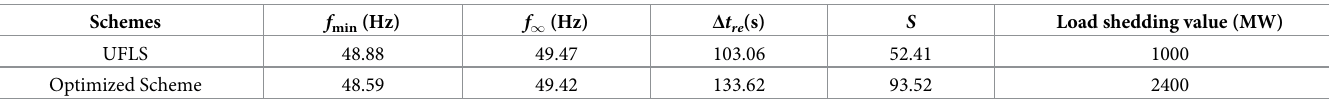
Table 9. Simulation analysis results for two schemes (Case 1).